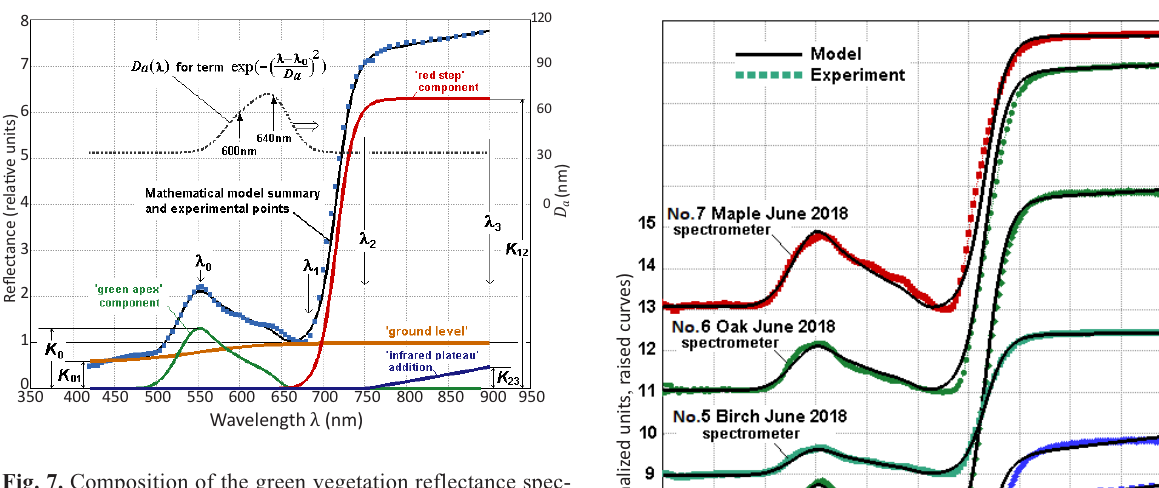
Fig. 7. Composition of the green vegetation reflectance spec ­ trum model from four addable components: slanted ground level, green apex, red edge step and infrared plateau. The definition of four adjustable 𝐾 ­parameters and mostly fixed four λ ­parameters is shown. In order to model the two minor bumps of the green apex at 600 nm and 640 nm, the width parameter 𝐷 𝑎 of the Gaussian function is increased near the respective wave lengths.